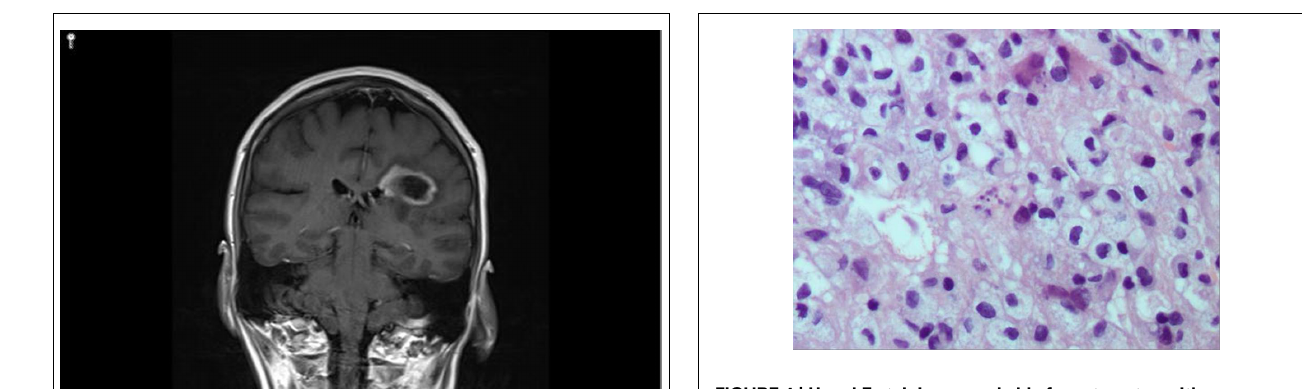
FIGURE 4 | H and Estaining remarkable for astrocytes with fragmented nuclear inclusions (Creutzfeldt-Peters cells) and numerous lipid-laden macrophages.